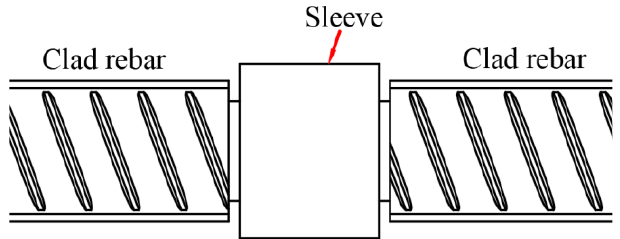
Figure 12. Diagram of the rebar sleeve connection.